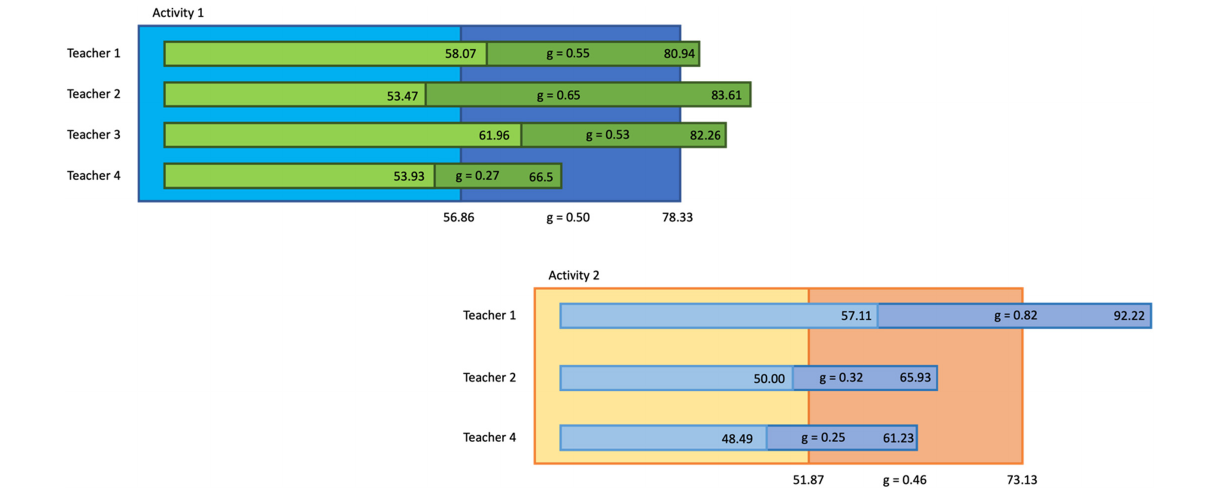
FIGURE 10 | Summary of results showing pre-test, post-test, and normalized learning gains (g) values for each group/teacher and in average, by activity.